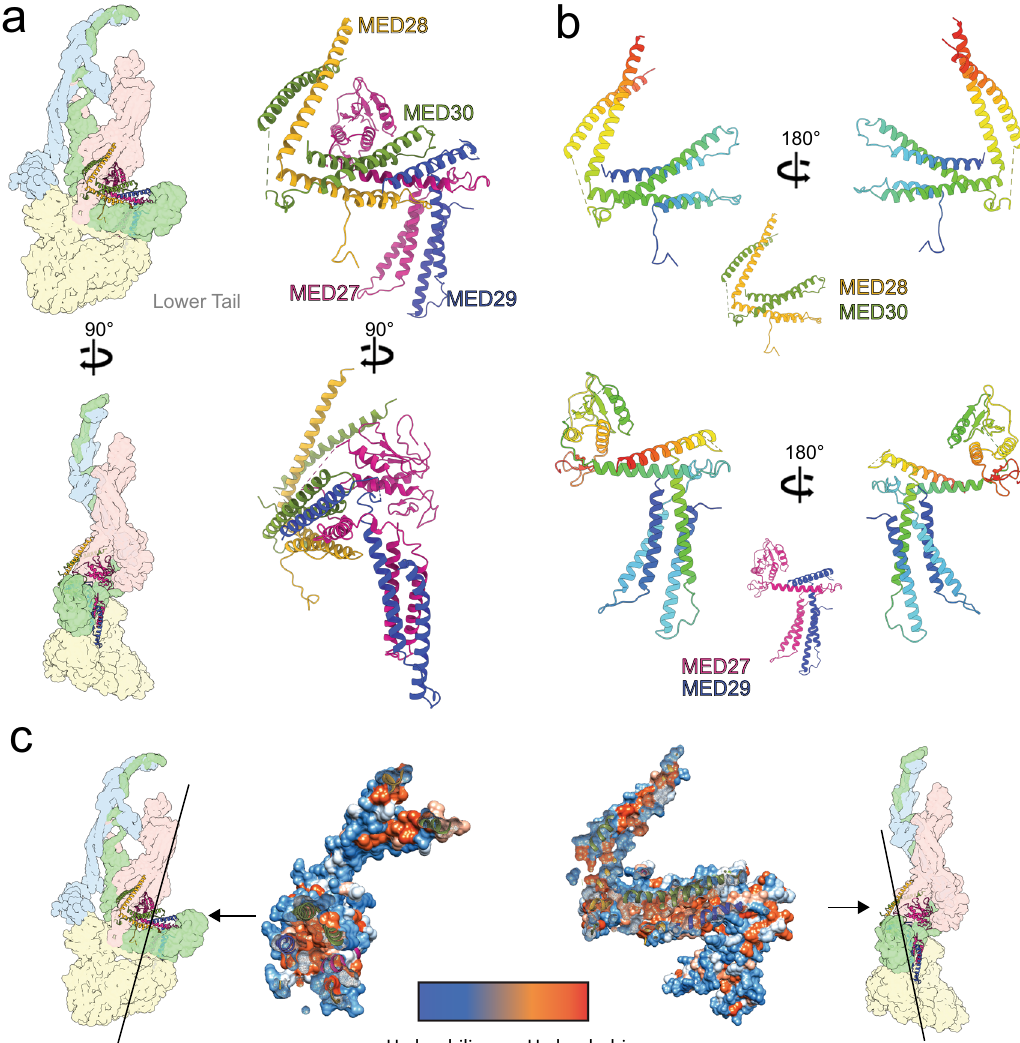
Fig. 4 Structure of the mammalian upper Tail. a Overall upper Tail structure and its position within the mMED structure (Head light red, MED14 light green, Middle light blue, and lower Tail light yellow). b The structure of all four upper Tail subunits (MED27 – 30) is remarkably similar, with the only deviation amongst them being the presence of a globular domain at the MED27 C-terminus. Subunit color changes from blue (N-terminus) to red (C- terminus). c Formation and stability of helical bundles in the upper Tail is driven by hydrophobic interactions between subunits. This is shown by slicing the upper Tail structure as indicated by the black